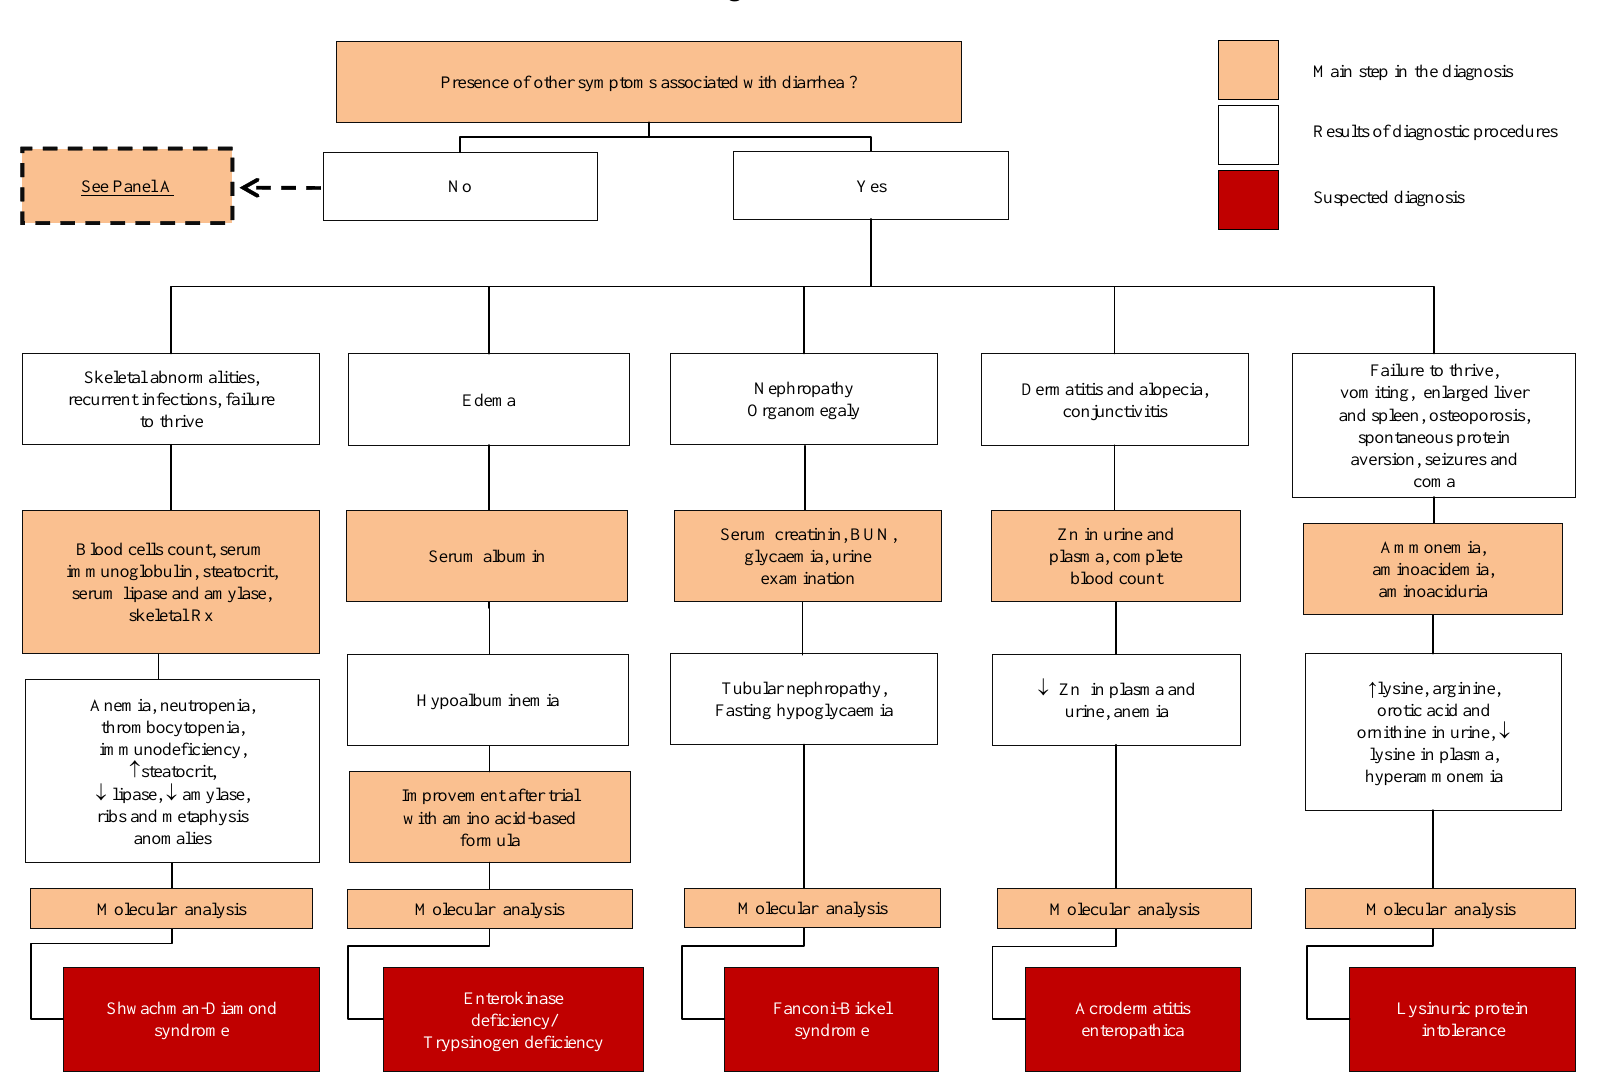
Figure 2. Panel B . Diagnostic diagram of congenital diarrheal disorders determined by an osmotic